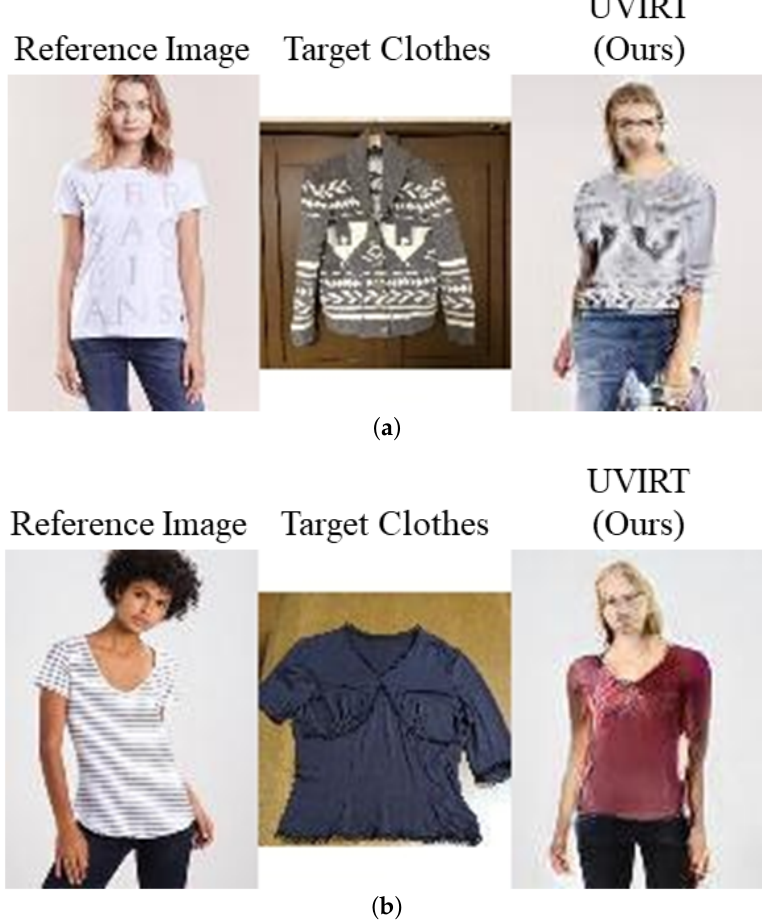
Figure 5. Failure case of our UVIRT. ( a ): The color of the target clothing change. Moreover, the face of the generated image is not reconstructed well because the generated image entangles the person and the clothing features. ( b ): Not only do the color of the clothing change but also the person changes because of the same reasoning discussed in ( a ). Table 2. Quantitative comparison of proposed UVIRT vs. CP-VTON on the test images of the